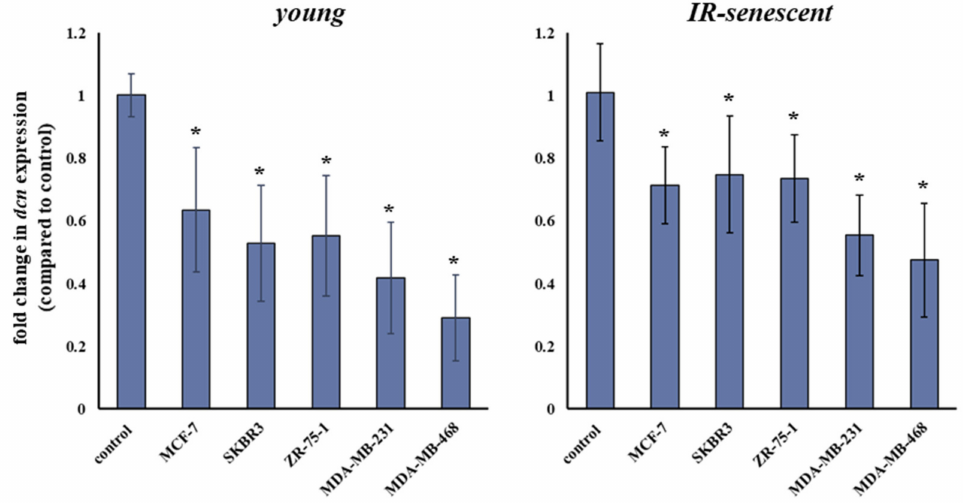
Figure 7. Human breast cancer cells decrease decorin expression in human stromal fibroblasts via a paracrine effect. Young and ionizing radiation (IR)-induced senescent human breast stromal fibroblasts were serum starved for 24 h and then incubated with media conditioned by the designated human breast cancer cell lines (MCF-7, SKBR3, ZR-75-1, MDA-MB-231 and MDA-MB-468) for another 24 h. RNA was extracted and decorin expression was assessed by real-time PCR after first- strand cDNA synthesis. Relative decorin mRNA levels to the respective untreated control with glyceraldehyde-3-phosphate dehydrogenase (GAPDH) serving as the reference gene are presented as means ± standard deviations of five independent experiments. Statistically significant differences from the respective untreated control are depicted by asterisks (*) (Student’s t test, p <